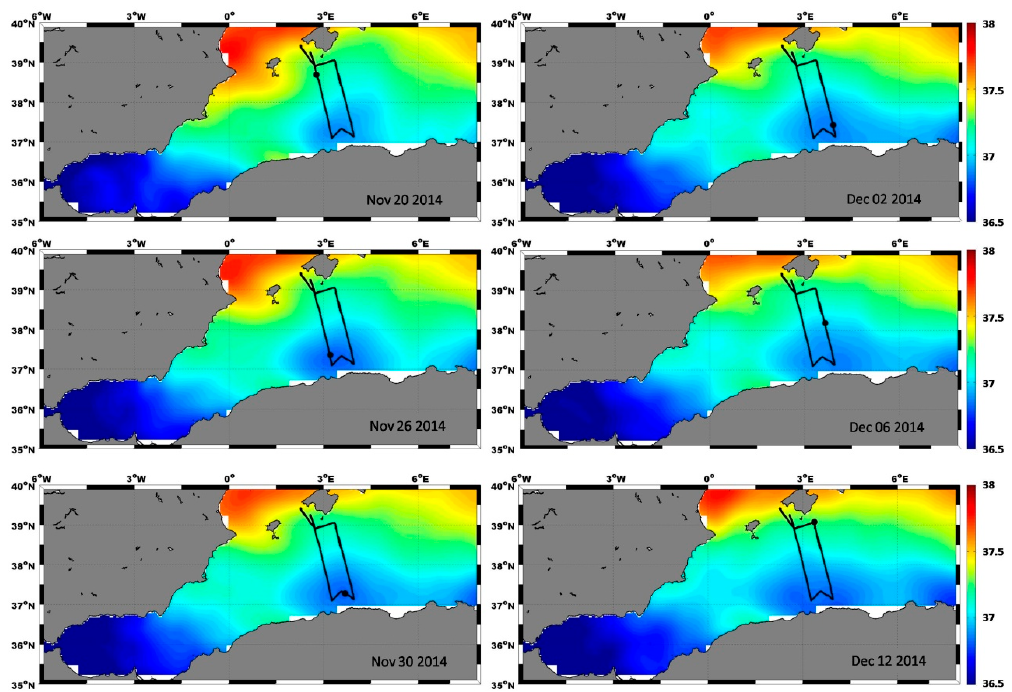
Figure 11. SMOS L4 SSS maps of the Alboran Sea and the Algerian Basin on six representative dates of the ABACUS 1.2 survey. Glider track in black.